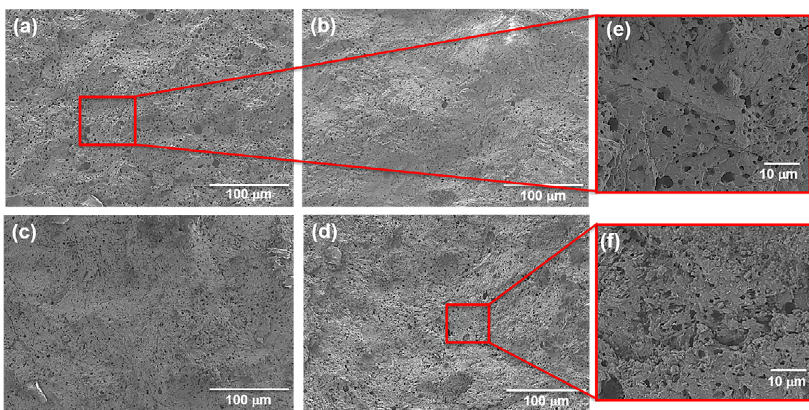
Figure 2. SEM micrographs of fracture surfaces of the LZS glass-ceramic without (a), with 1, 2.5, and 5 vol.% (b, c, and d, respectively) alumina additions after fast firing at 900 ºC for 30 min and LZS glass-ceramic (e) and LZS with 5 vol% alumina additions (f) for a high magnification.